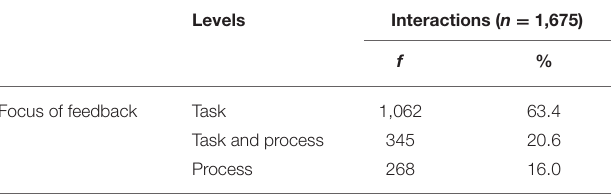
TABLE 5 | Frequency of interaction for the levels of feedback.